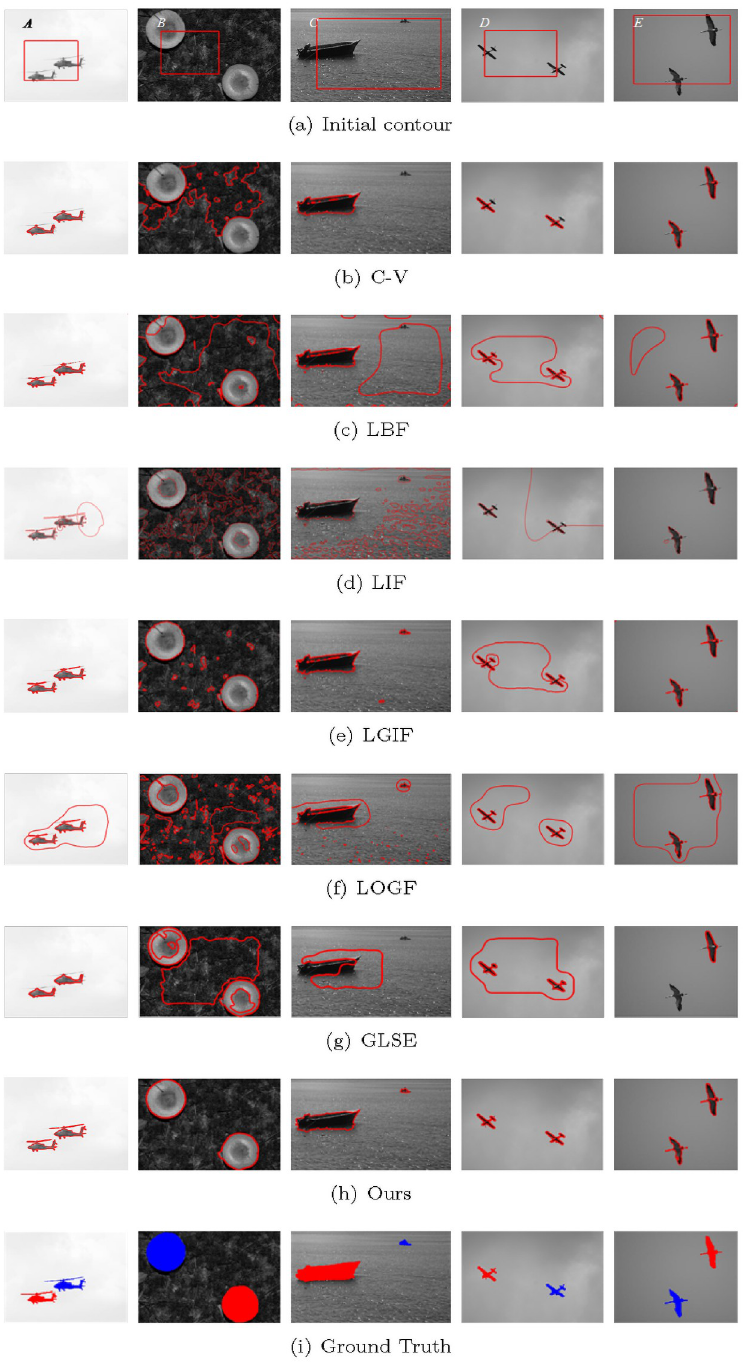
Fig 11. Experiments on standard